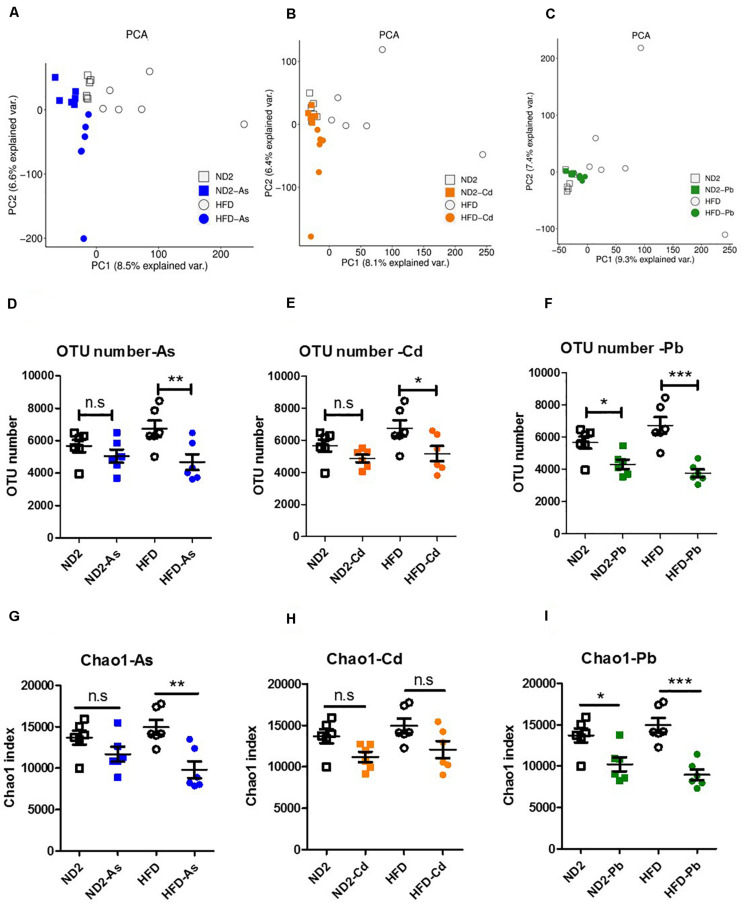
Diet effects on gut microbiota disturbance upon As, Cd, or Pb exposure. ND- and HFD-fed mice were exposed to 100 ppm As, Cd, or Pd for 10 weeks (n = 6 for each group). Cecum feces was collected for gut microbiota analysis by 16S rRNA gene sequencing. (A–C) Principal coordinate analysis (PCA) based on an unweighted UniFrac analysis of the intestinal microbial composition where samples of ND-/HFD-fed mice upon As, Cd, or Pb exposure are highlighted with different colors. The position and distance of data points indicate the degree of similarity in terms of both presence and relative abundance of bacterial taxonomies. (D–F) Number of observed OTUs. Data (mean + SEM) represent 16S rRNA gene 454-pyrosequencing analysis of intestinal microbiota of mice. (G–I) Chao1 index of microbial diversity. Statistics according to two-way ANOVAs and Bonferroni post hoc tests. n.s. not significant; *P < 0.05; **P < 0.01; ***P < 0.001.